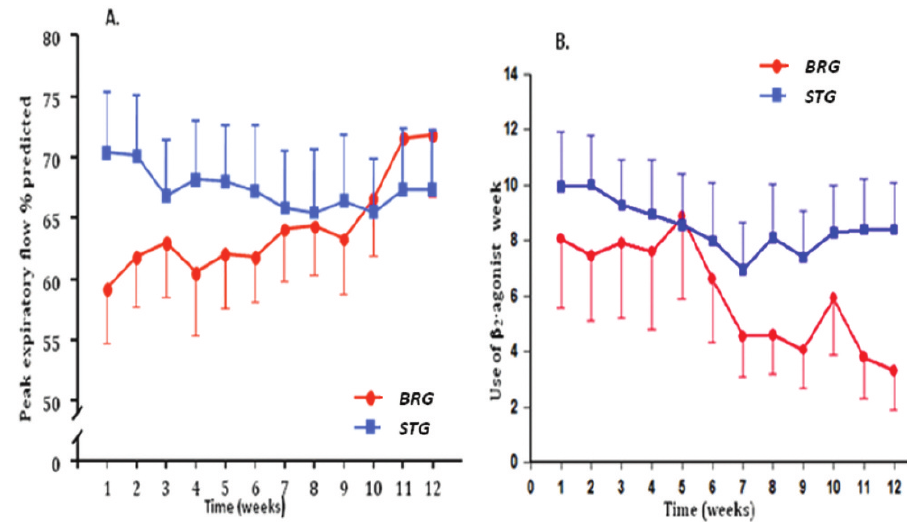
Figure 3 - Weekly peak flow rate measurements (3A) and daily use of b 2 agonist (3B) were monitored over three months. Peak flow rate progressively and significantly increased in the BRG (p , 0.05) but remained stable in the STG (Figure 3A). In the BRG, the use of b 2 agonist (salbutamol) as a relief medication (Figure 3B) decreased over time, particularly after the sixth week (p , 0.05)